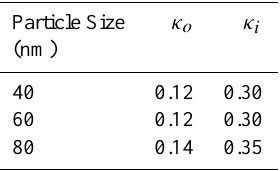
Table 1. κ o and κ i values for 40, 60, and 80nm